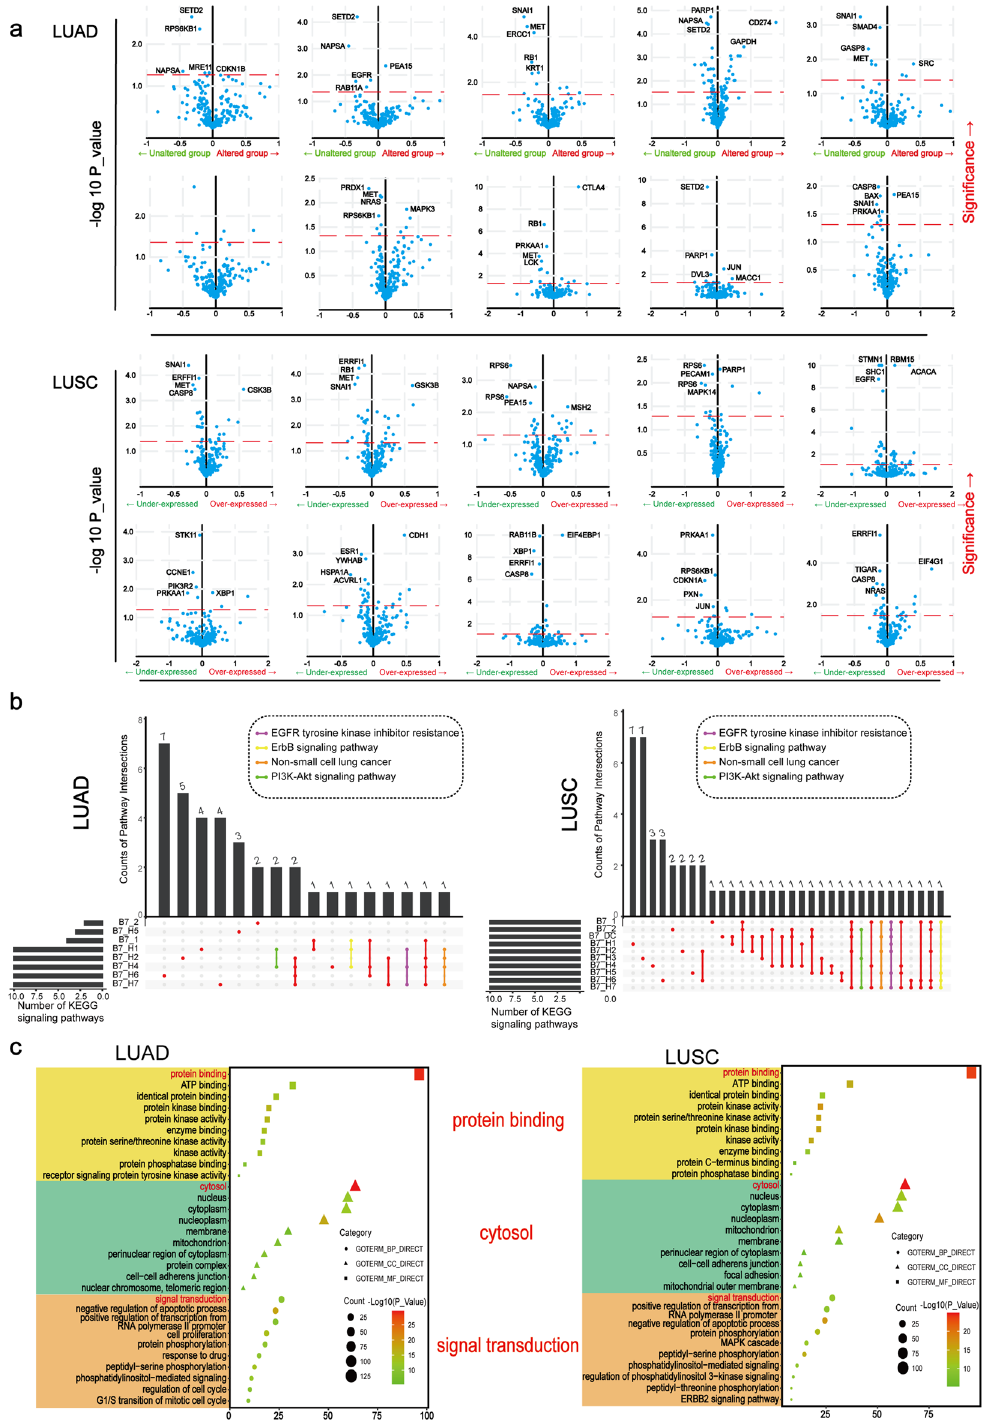
Figure 4. GO and KEGG enrichment analysis of B7 family. ( a ) Enrichmentof differentially expressed proteins of B7 family in NSCLC. − log10 ( P value) = 1.30 is considered to be cut-off value for difference. The distance of expression level change was based on logarithmic ratio (mean in altered/mean in unaltered). ( b ) Intersection of top10 important KEGG signaling pathways for each B7 family member. ( c ) The influence of B7 family on downstream processes were analyzed by GO enrichment analysis via